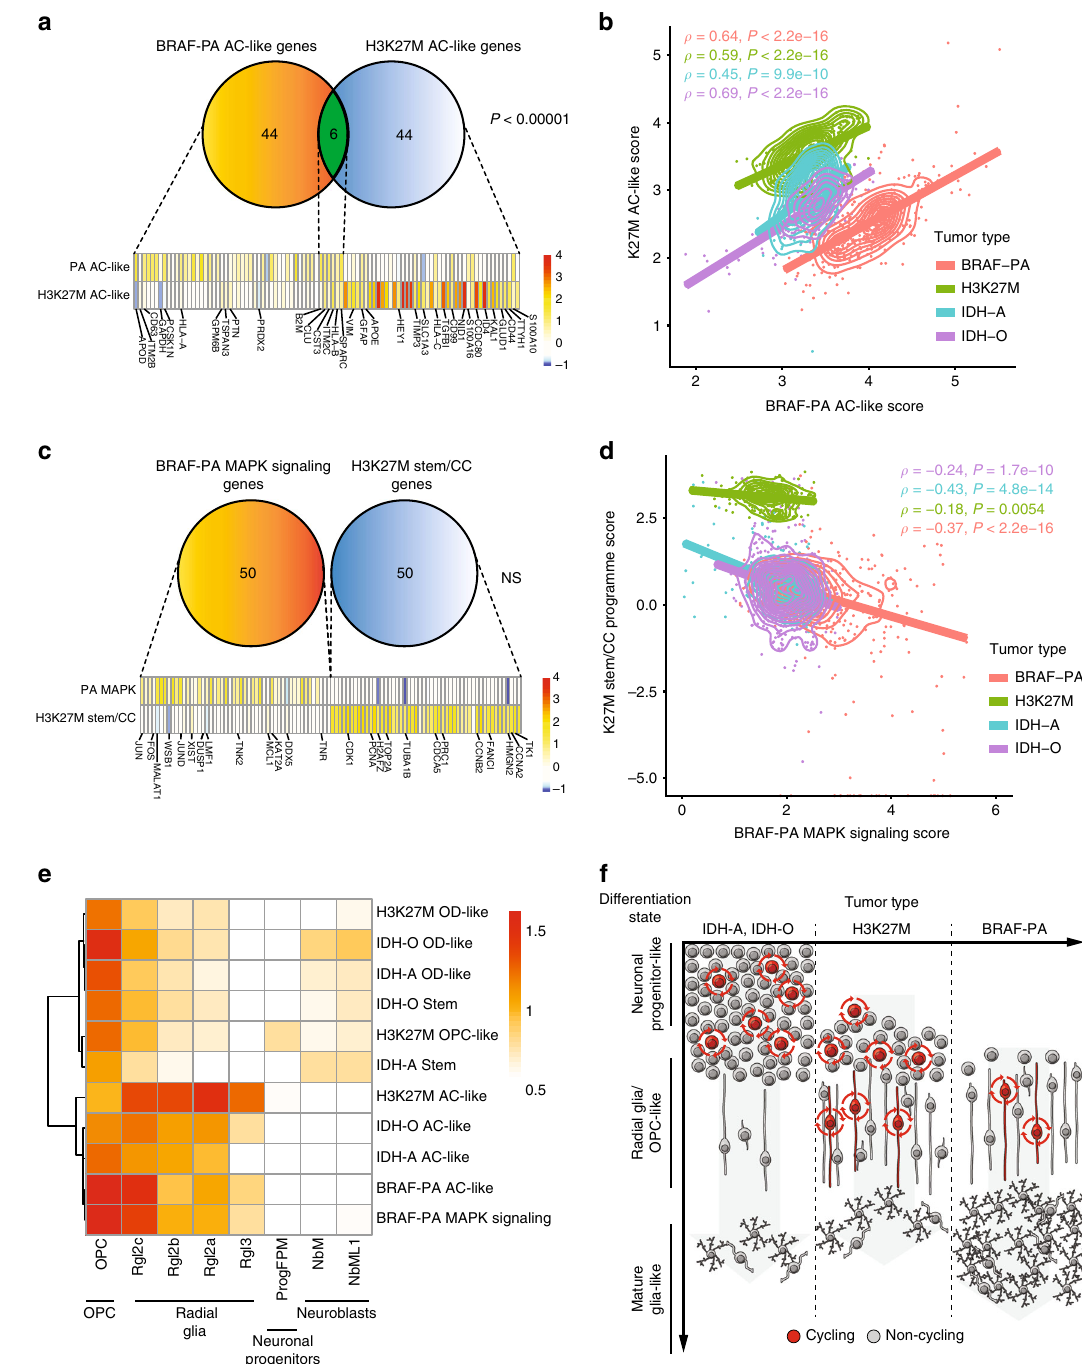
Fig. 10 Gene programme comparisons between low-grade and high-grade pediatric brain tumors. a Venn diagram showing overlap between PA AC-like gene programme and H3K27M AC-like gene programme 4 , along with heat map showing average expression of genes from all AC-like programme. P-value represents signi fi cance of overlap based on Fisher ’ s exact test. Heat map shows average expression of genes from either gene programme in PA and H3K27M cells. Color scale represents average expression z -score. b Single cells from PA tumors, intermediate-grade IDH astrocytomas 2 (IDH-O) and IDH oligodendrogliomas 3 (IDH-A), and from high-grade H3K27M pediatric midline gliomas 4 (H3K27M) are plotted based on expression of the PA AC-like gene programme, and of a H3 AC-like gene programme. Spearman ρ and associated P-values are shown for correlation between the two signatures within cells from each tumor type. c Venn diagram showing lack of overlap between PA MAPK signaling gene programme and H3K27M stem/cellcycle gene programme 4 . Heat map shows average expression of genes from either gene programme in PA and H3K27M cells. Color scale represents average expression z -score. d Single cells from PA and H3K27M-mutated pediatric midline gliomas are plotted based on expression of the PA MAPK signaling gene programme, and of the stem/cell-cycle gene programme derived from H3K27M tumors. e Heat map showing enrichment for human developing midbrain cell type signatures 30 among subpopulations of cells in PA and other glioma types. Color scale shows signature enrichment score. f Model for glioma differentiation hierarchies re fl ecting differences in compartment, abundance of cycling cells, differentiation state, and population structure of PA compared to IDH-O and IDH-A gliomas, and to H3K27M